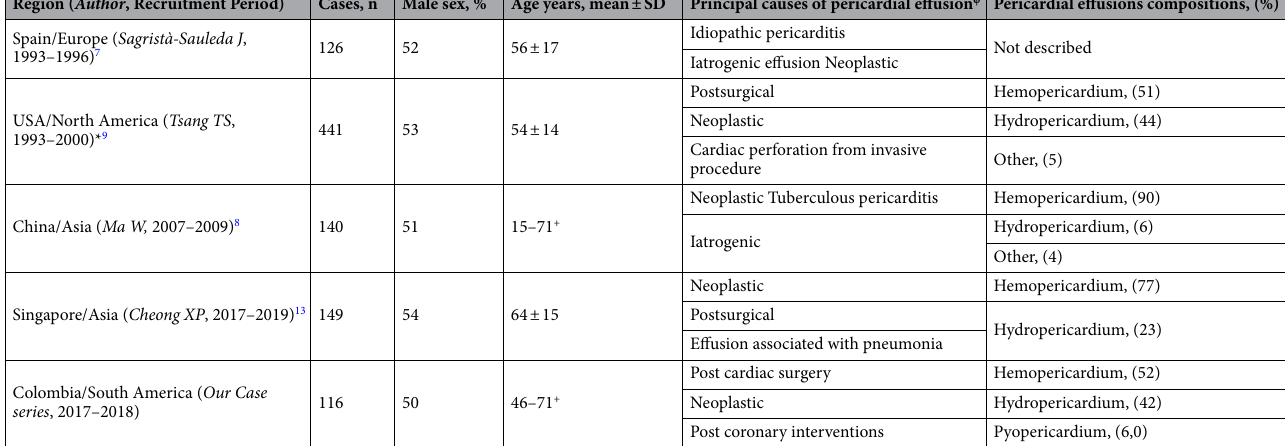
Table 3. Principal demographic and clinical characteristics of series of pericardiocentesis. *Last period of the series between 1993–2000. + Age reported in interquartile range (IQR). ϕ The three principal causes reported in each case